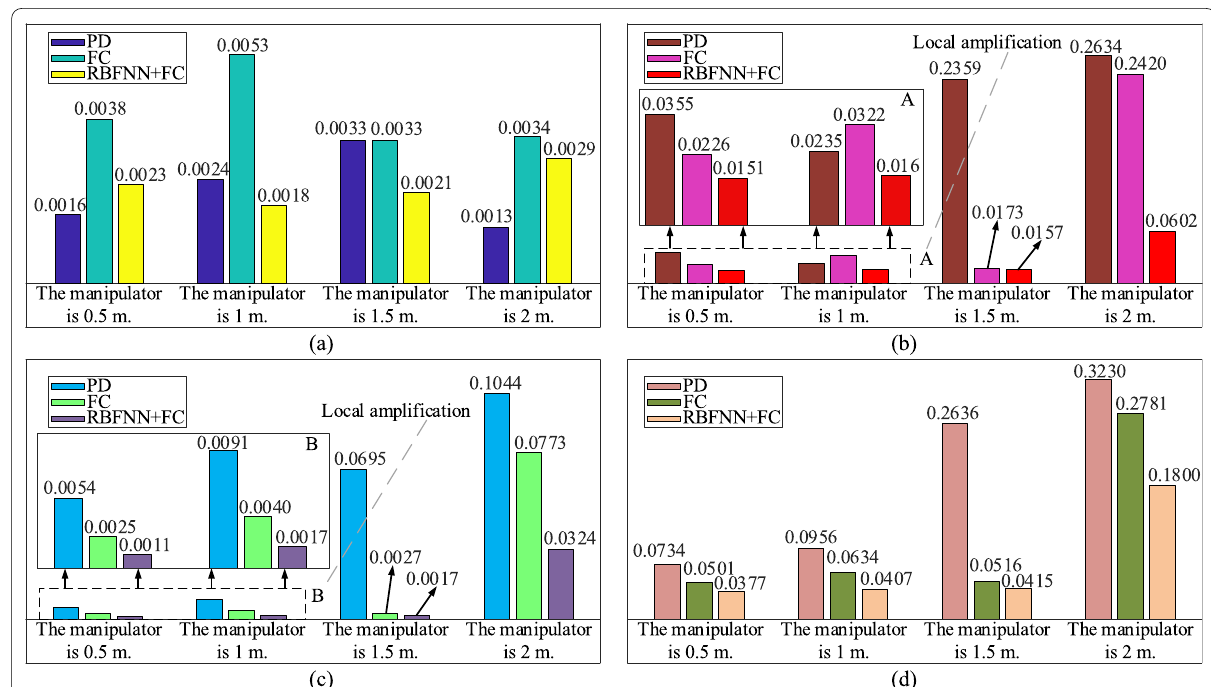
Figure 16 Histogram of error evaluation index: ( a ) Means of errors, ( b ) Means of absolute errors, ( c ) Variance of errors, ( d ) Standard deviation of